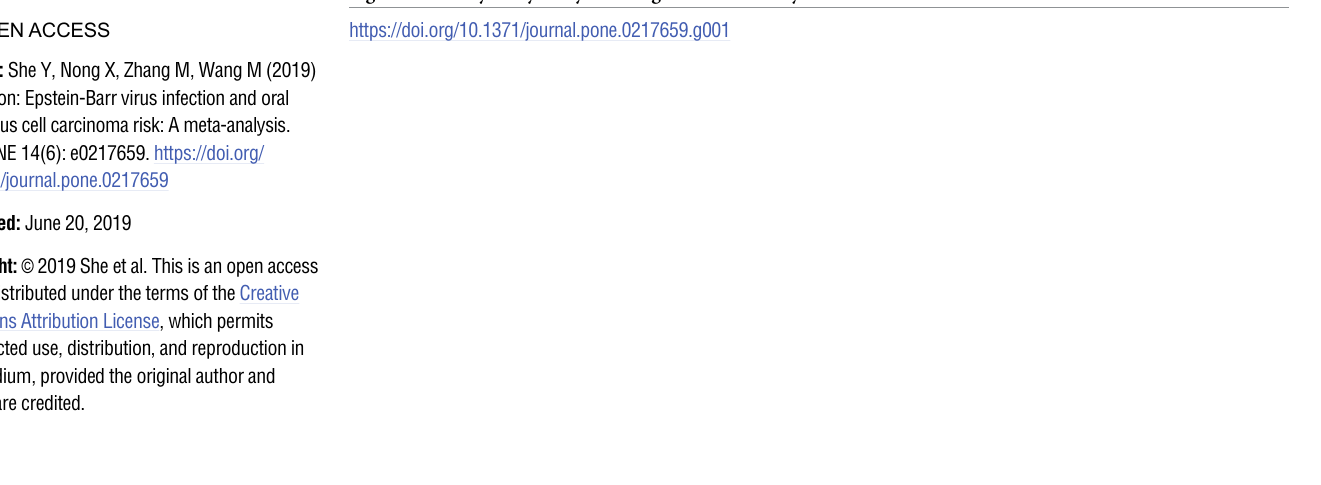
Fig 3. Sensitivity analyses by omitting individual